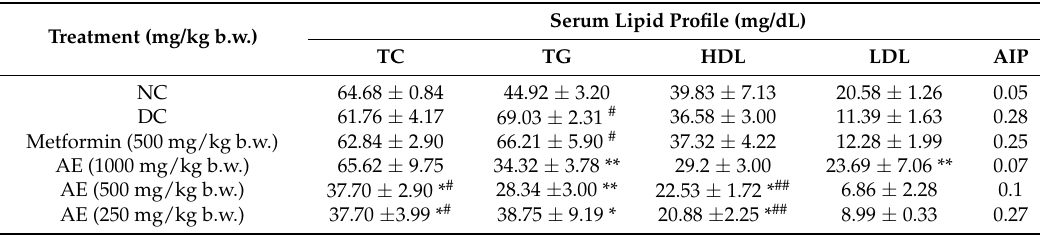
Table 2. Effect of twice daily oral administration of different doses of AE for 12 days on the serum lipid profiles of normal and STZ-induced diabetic rats. Treatment (mg/kg